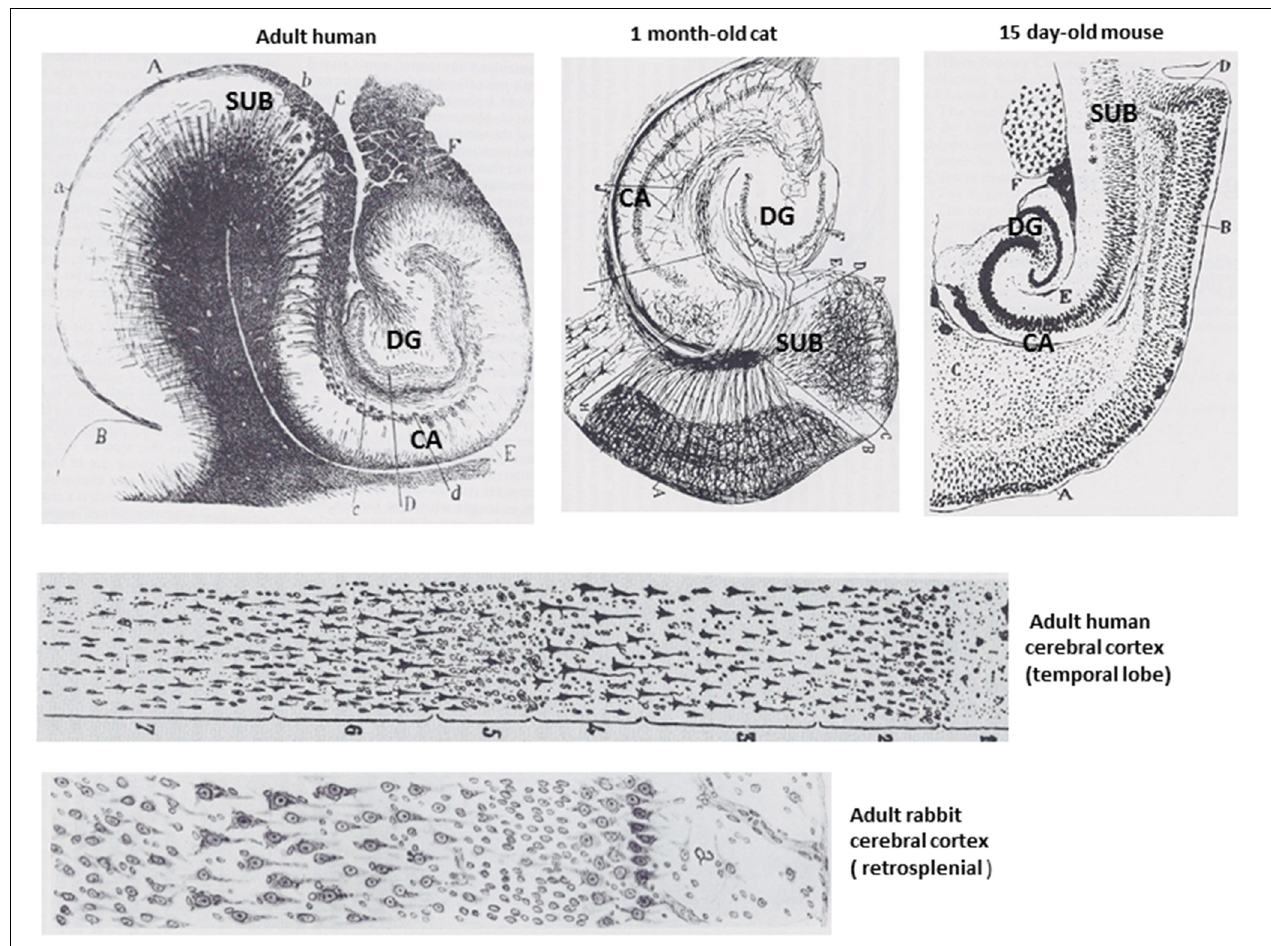
FIGURE 2 | Structural features of the brains of mammals are conserved from rodents to humans. The upper drawings show the hippocampal formation of an adult human, a kitten and a young mouse. The lower two drawings show the cellular organization of the cerebral